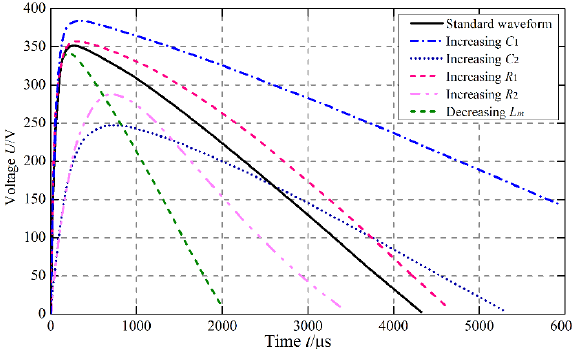
Figure 8. Simulated waveforms of SI voltage.